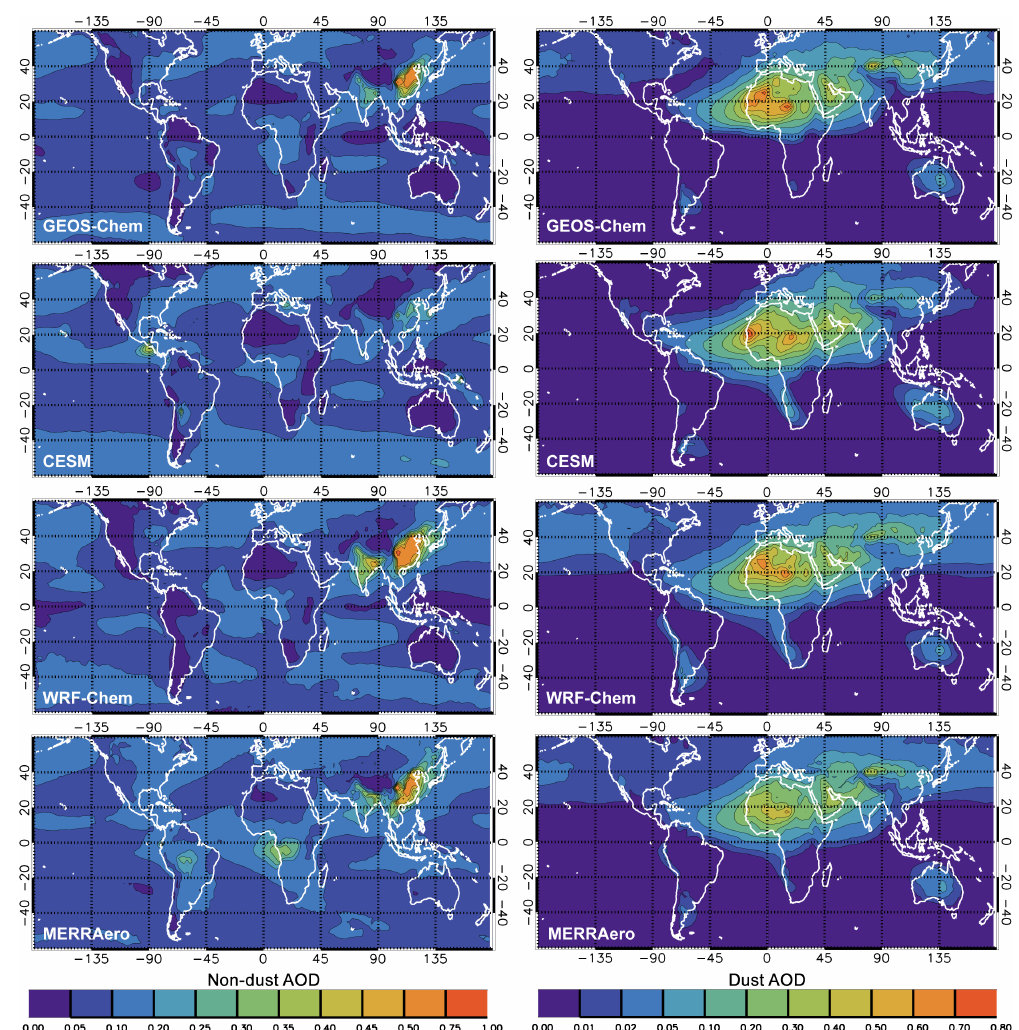
Figure 2. Annual non-dust AOD (left) and dust AOD (right) at 550nm for the four models used in this study. Data are averaged over